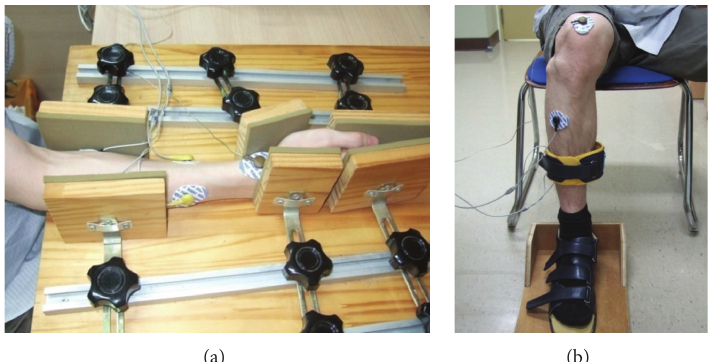
Figure 1: (a) The apparatus for fastening the forearm during isometric wrist flexion and extension. (b) The apparatus that made for foot and leg fixation for EMG recording during isometric ankle dorsiflexion. The sole of the shoe is attached to the board for isometric